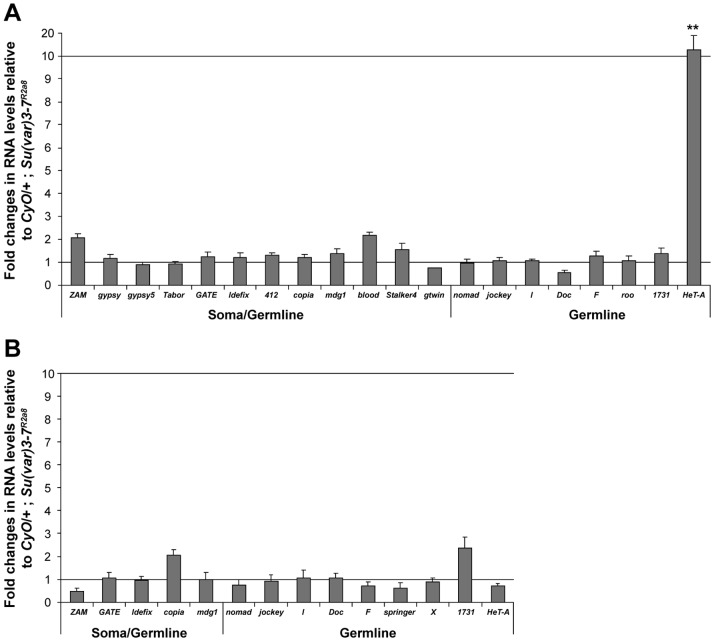

Su(var)3–7 does not interact with piwi and aubergine for transposon silencing in ovaries.Quantitative RT-PCR analysis on the indicated transposons in (A) piwi2/+; Su(var)3–7R2a8 and (B) aubQC42/+; Su(var)3–7R2a8 ovaries. Bars represent the fold changes in RNA levels relative to Su(var)3–7R2a8 siblings (n = 3; ** : p<0,01).